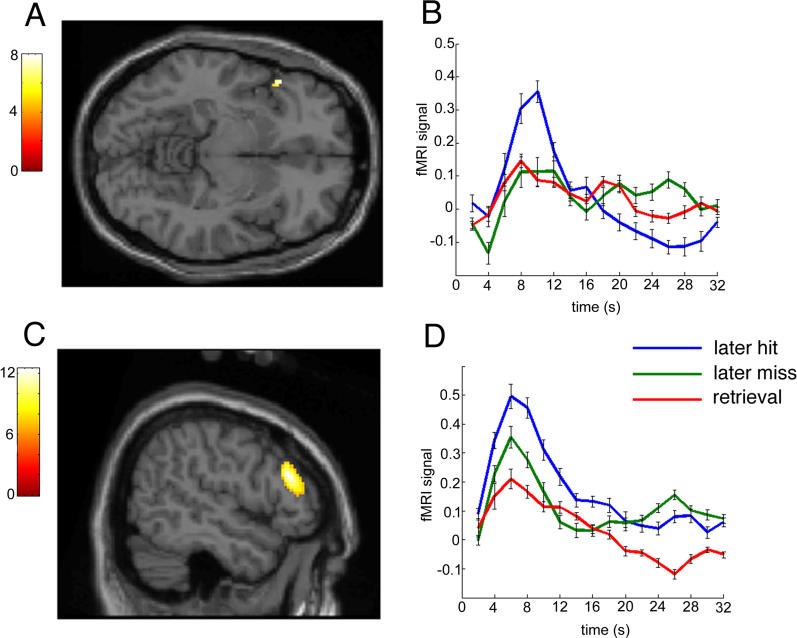
Event-Related fMRI Analyses: PFC(A) Left ventrolateral prefrontal region exhibiting DM effects (Talairach coordinates: −48, 21, −9). The scale refers to F values.(B) Mean HRFs (averaged across participants, with standard error bars) observed at this region for later hits (blue), later misses (green), and unsorted retrieval trials (red). HRF for later hits peaked at ˜10 s.(C) Right dorsolateral prefrontal region exhibiting DM effects (Talairach coordinates: 53, 30, 21).(D) Mean HRFs for this region.